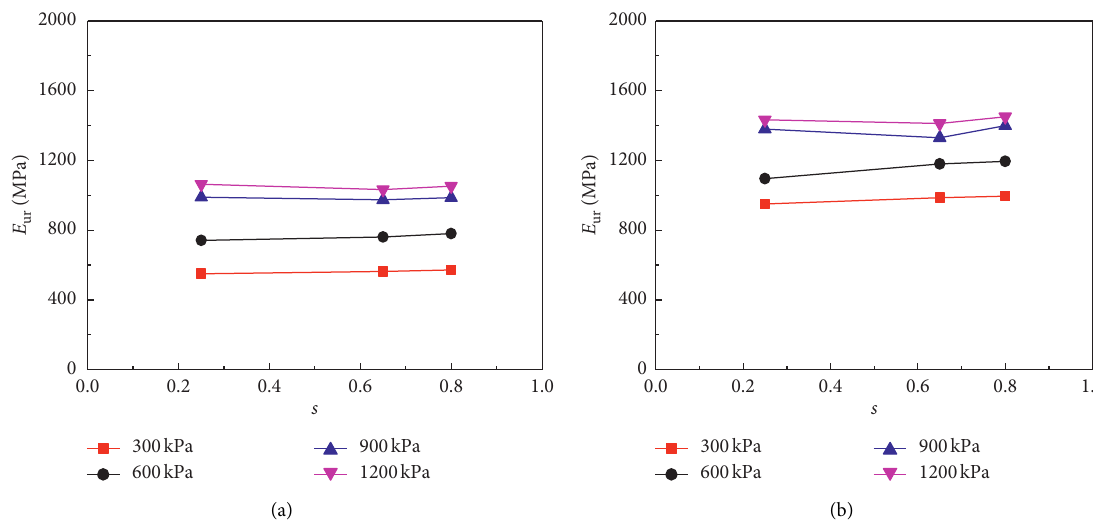
Figure 9: Relationship between the modulus of resilience, E